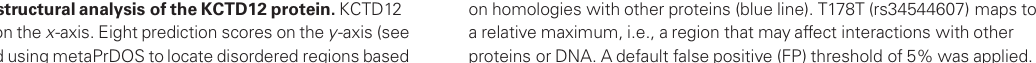
on homologies with other proteins (blue line). T178T (rs34544607) maps to a relative maximum, i.e., aregion that mayaffect interactions with other proteins or DNA. Adefault false positive (FP) threshold of 5% was